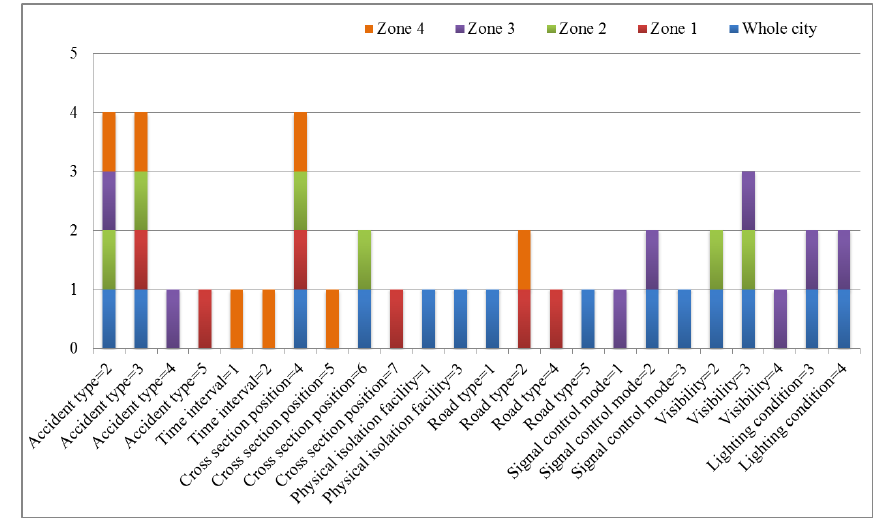
Figure 3. Comparative analysis of influencing factors.